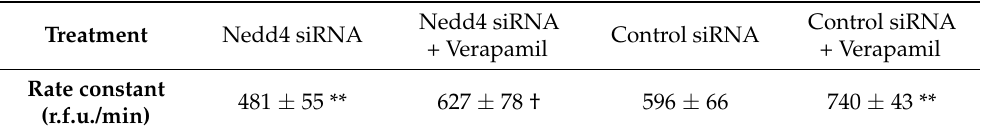
Table 1. Intracellular calcein accumulation rates were calculated using the fluorescence data obtained over the final five minutes of the calcein-AM assay as depicted in Figure 1c. Data (mean ± SEM) are representative of three independent experiments, each performed with eight biological replicates. ** p ≤ 0.01 compared with control. † p ≤ 0.01 compared with Nedd4 siRNA-treated cells. Treatment